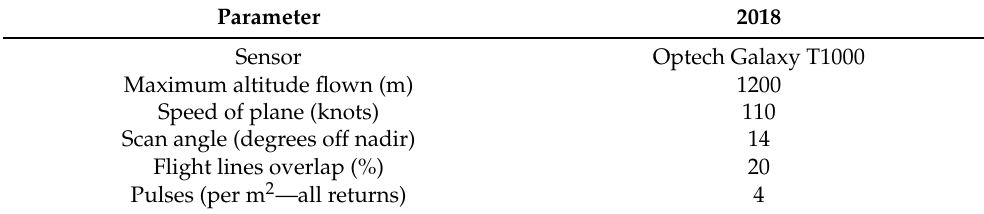
Table 4. Lidar acquisition